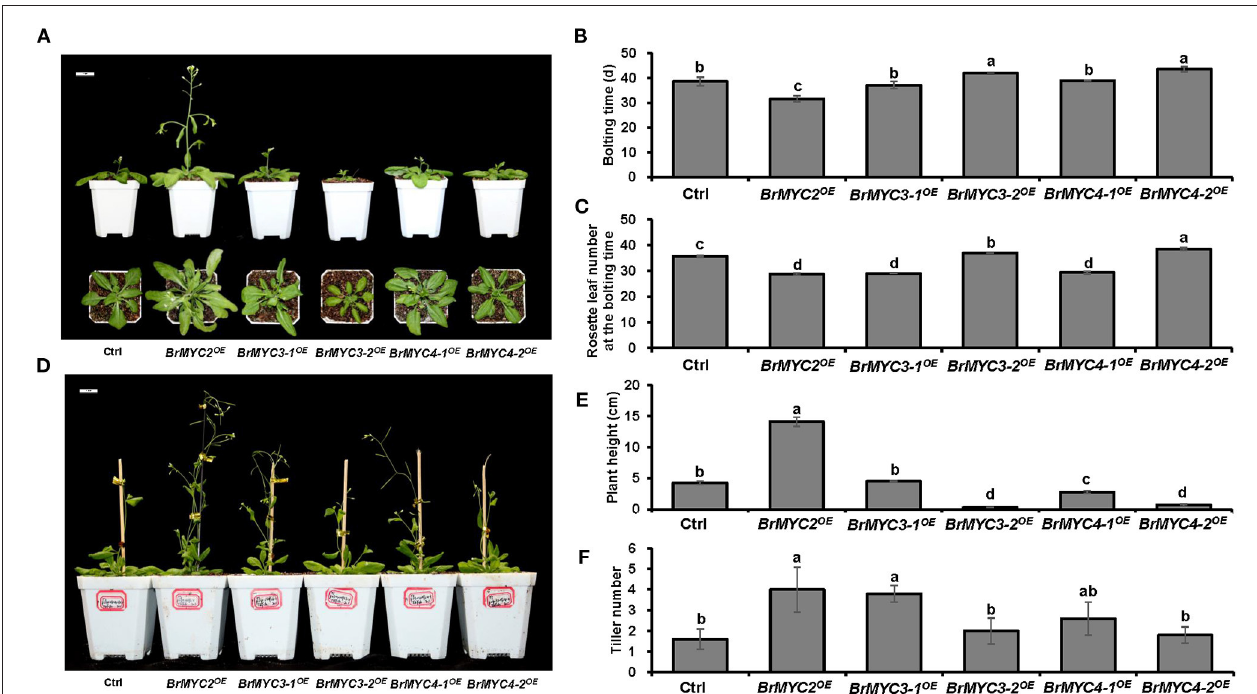
FIGURE 7 | Plant height and flowering time of transgenic Arabidopsis . (A) Phenotype of 3-week-old Arabidopsis . (B) Bolting time. (C) Rosette leaf number at the bolting time. (D) Phenotype of 7-week-old Arabidopsis . (E) Plant height. (F) Tiller number. Transgenic lines are Ctrl, BrMYC2 OE , BrMYC3-1 OE , BrMYC3-2 OE , BrMYC4-1 OE , and BrMYC4-2 OE . Data are shown as mean ± SD from three independent biological replicates. ANOVA was used for statistical analysis, followed by Tukey’s multiple comparison test ( p < 0.05). Bar = 1cm.